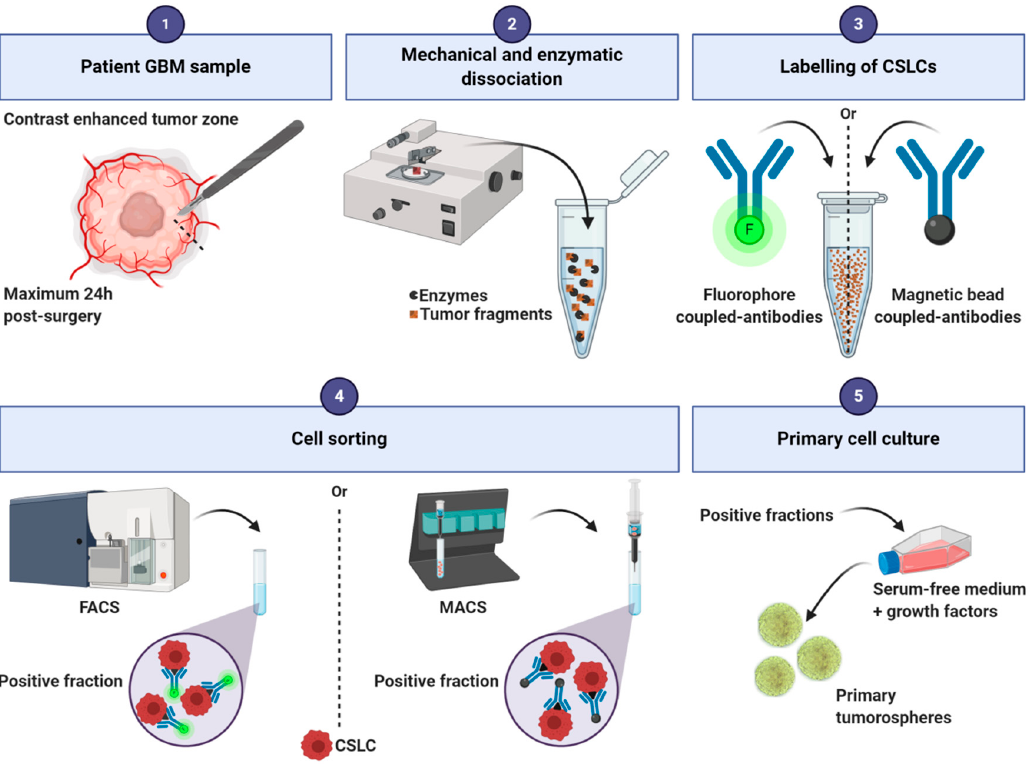
Figure 2. Main steps of the sorting protocol for human glioblastoma tumorospheres production. CSLCs: cancer stem-like cells; FACS: Fluorescence-activated cell sorting; MACS: Magnetic-activated cell sorting.